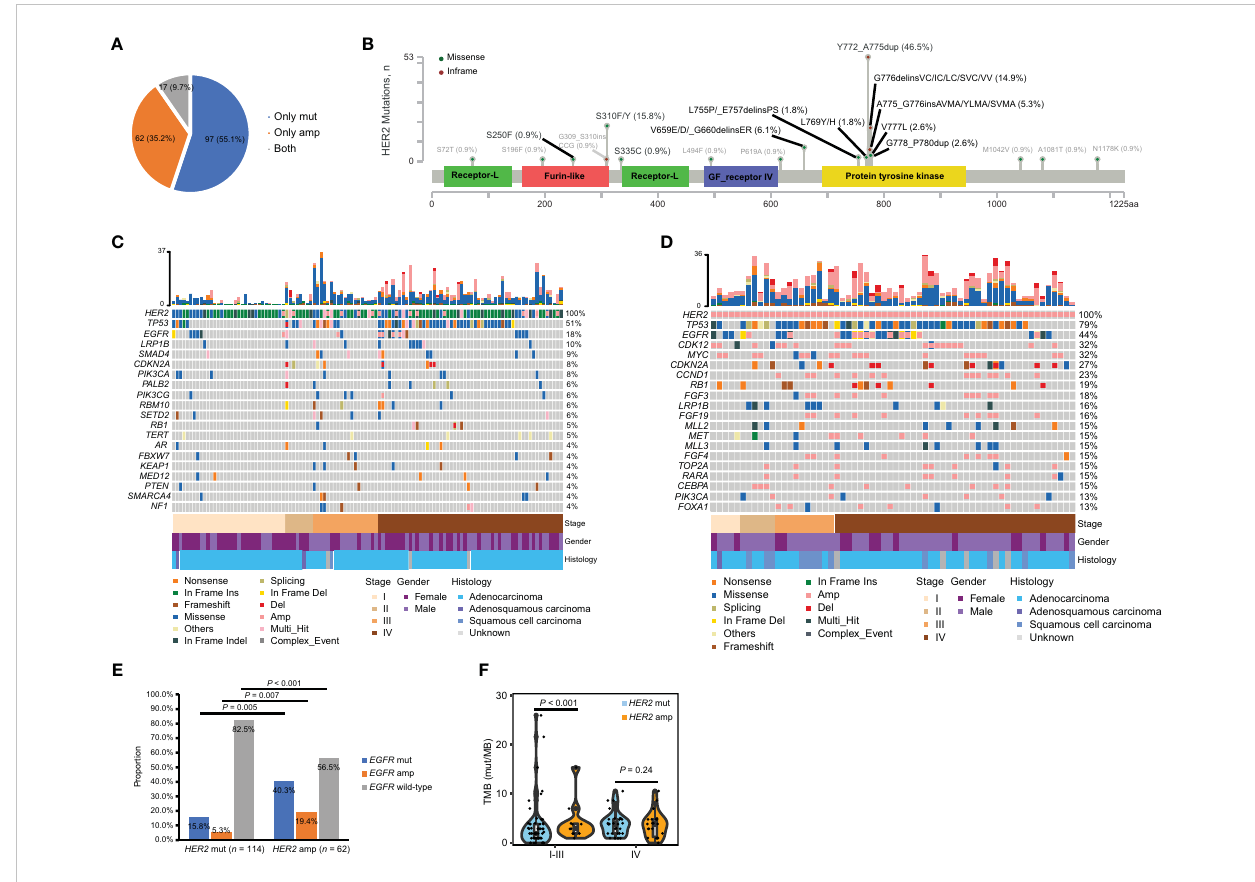
FIGURE 1 Incidence and co-mutation pro fi les among treatment-naïve HER2 -altered NSCLC patients from the geneplus dataset. (A) Pie plot showing the incidence of HER2 mutation only ( n = 97), HER2 ampli fi cation only ( n = 62) or both HER2 mutation and ampli fi cation ( n = 17) within our cohort. (B) Oncogenic (black) and non-oncogenic mutations (gray) in HER2 -mutant patients were localized to HER2 protein. (C, D) Heatmap displaying the mutation landscapes of patients with HER2 mutations ( n = 114) (C) and with HER2 ampli fi cation only ( n = 62) (D) . Each column represents data from a single patient. The number of somatic mutations of each patient and the mutation frequency of each gene are shown in the top and right respectively. The bottom heatmaps indicate key patient characteristics. (E) The proportion of EGFR mutation, ampli fi cation and EGFR wild-type in patients with HER2 mutations ( n = 114) and with HER2 ampli fi cation only ( n = 62). (F) Difference of TMB between patients with HER2 mutations ( n = 106) and with HER2 ampli fi cation only ( n = 60) in early- and late-stage disease respectively. Amp, ampli fi cation; mut, mutation; TMB, tumor mutation